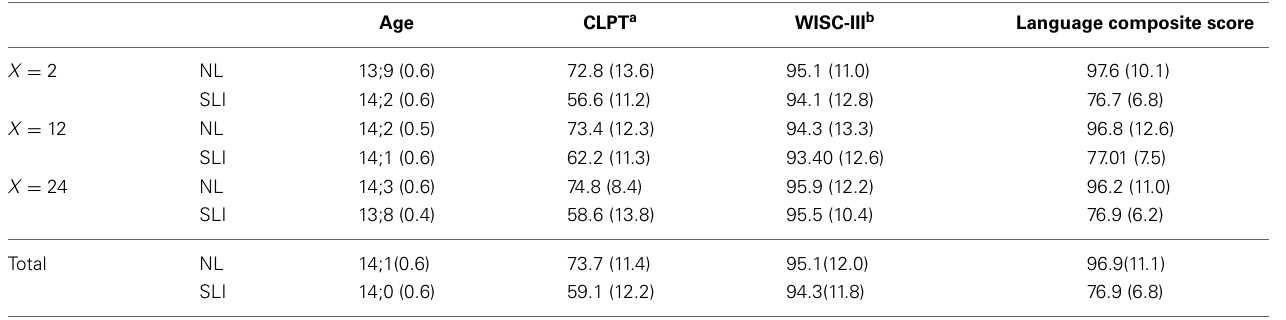
Table 1 | Group summary statistics for the adolescents with specific language impairments (SLI) and with normal language (NL) in the low ( X = 2), mid ( X = 12), and high ( X = 24) variability conditions.